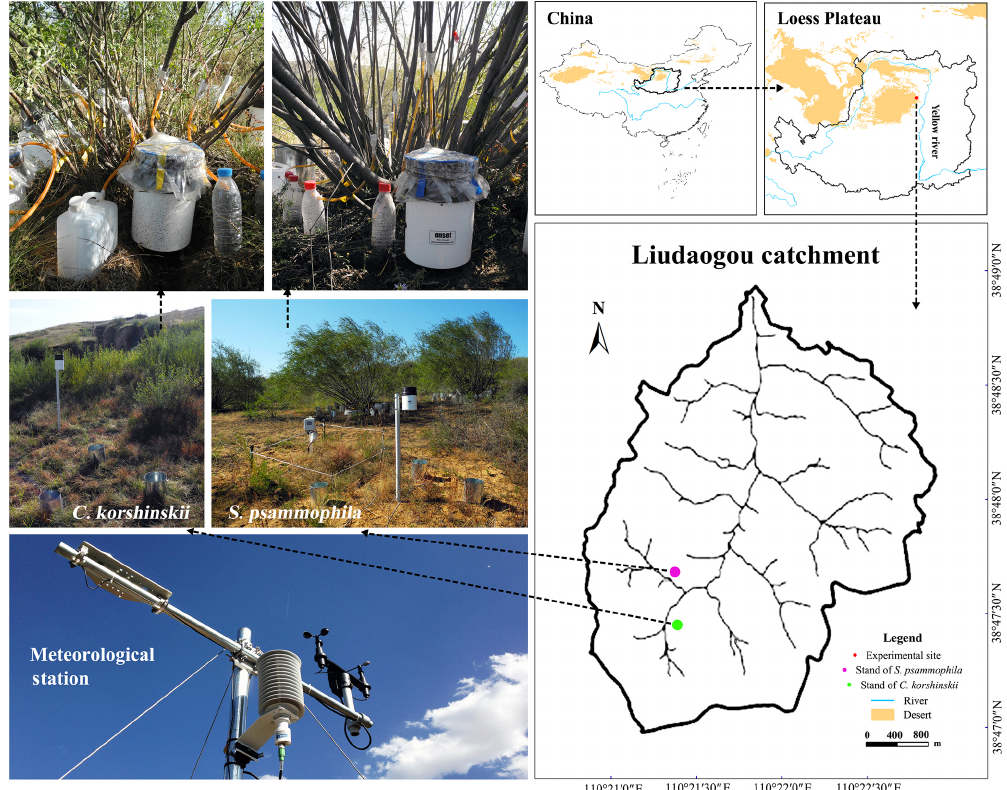
Figure 1. Locations and experimental settings in the plots of C. korshinskii and S. psammophila . Table 1. Branch morphologies of C. korshinskii and S. psammophila for stemflow